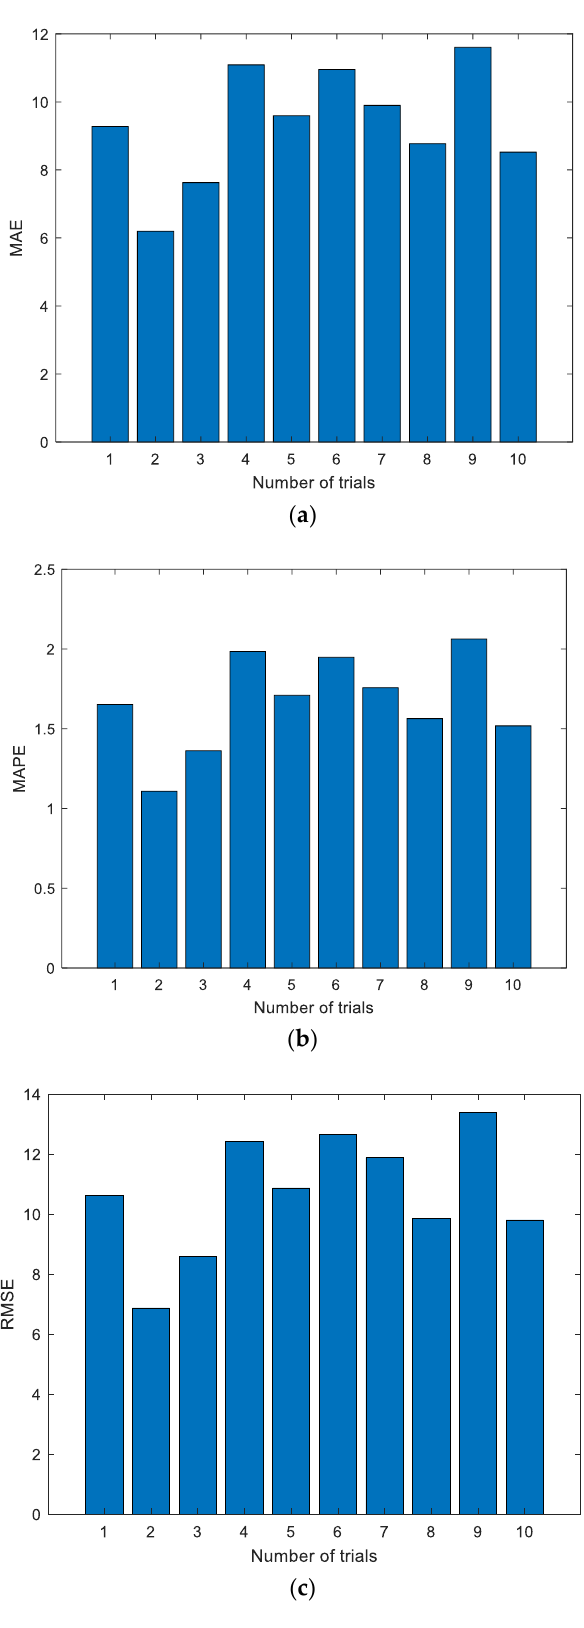
Figure 10. Evaluation metrics of ELM prediction using the third group of data. ( a ) MAE; ( b ) MAPE; ( c ) RMSE.